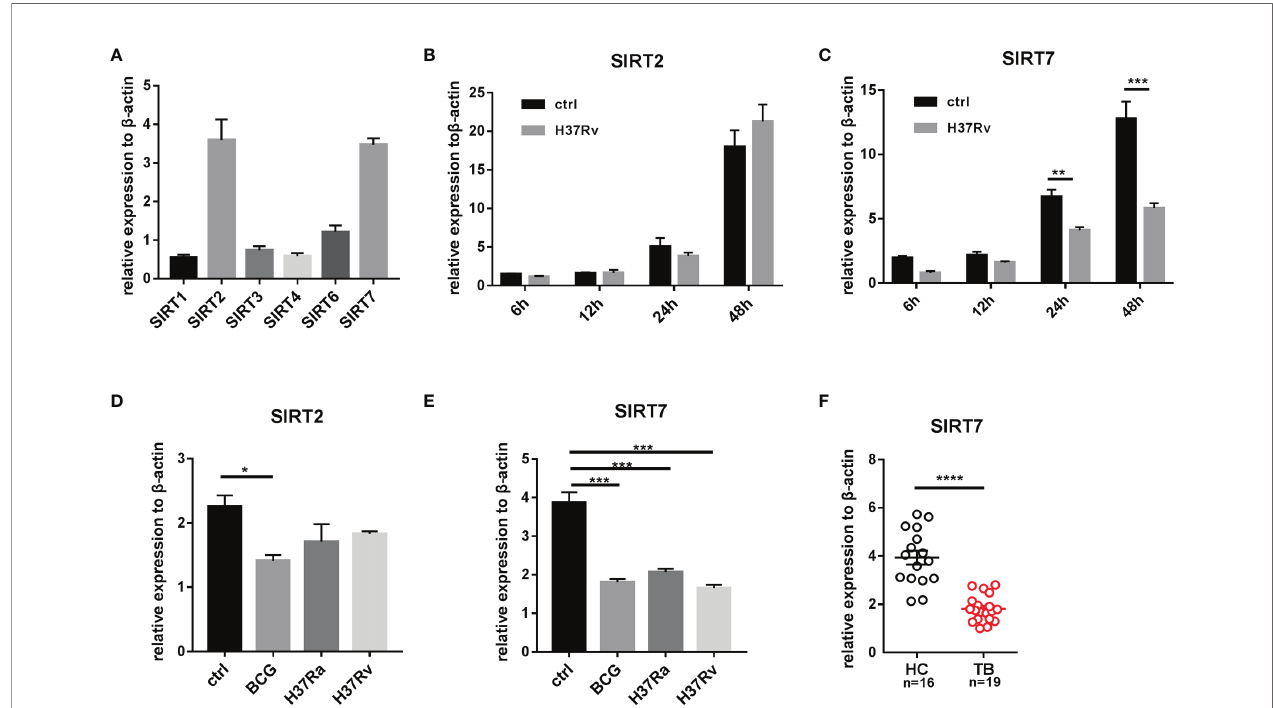
FIGURE 1 | Mycobacteria infection downregulates SIRT7 expression as determined by quantitative RT-PCR analysis. (A) Expression levels of sirtuin family members in Raw264.7 cells. (B, C) SIRT2 and SIRT7 mRNA expression in Raw264.7 cells at 6, 12, 24, and 48 h after infection with H37Rv (MOI 10:1). (D, E) SIRT2 and SIRT7 mRNA expression in Raw264.7 cells infected with Mycobacterial strains with differing virulence. Cells were infected with BCG, H37Ra, and H37Rv, respectively (MOI 10:1) for 4 h, then SIRT2 and SIRT7 expression levels were analyzed 24 h after infection. (F) Differences in expression of SIRT7 in hMDMs from healthy individuals and patients with TB. Data are representative of three independent experiments with similar results and are presented as means ± SD. Two way ANOVA was performed in (B, C) , One way ANOVA was performed in (D, E) , Unpaired Student ’ s t-test was used in (F) . *p < 0.05; **p < 0.01; ***p < 0.001; ****p<